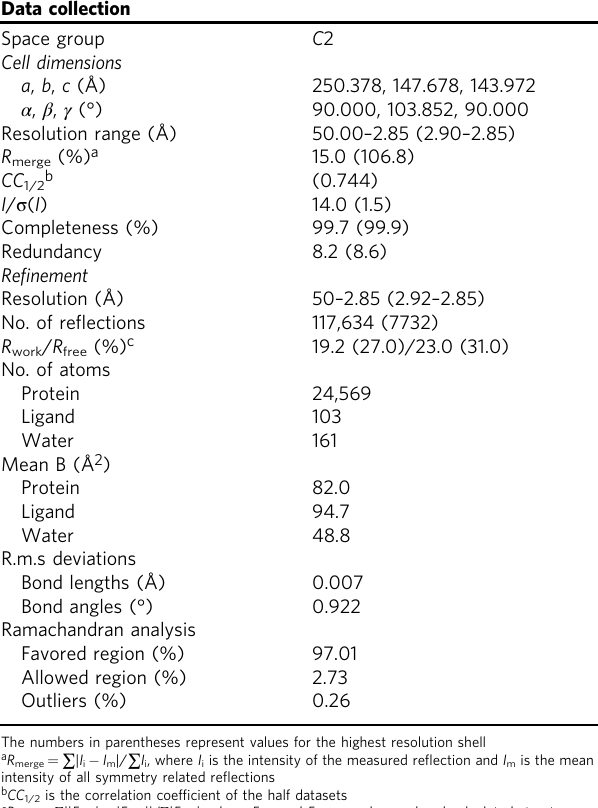
Table 1 Summary of binding af fi nities measured by ITC between various fragments of liprin- α s and LAR-RPTPs.